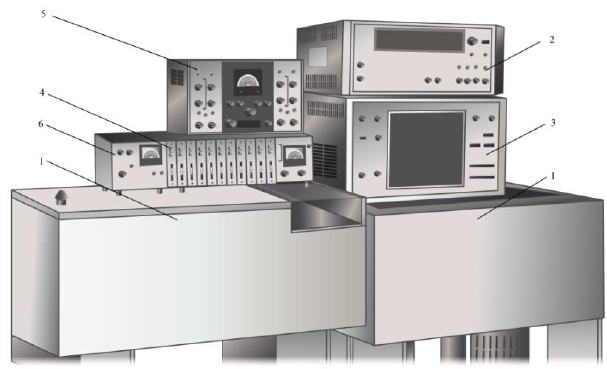
Figure 22. Test Unit Overview: 1 – centrifuge with rotor, 2 – F 5034 frequency meter, 3 – H 043.1 electromagnetic oscillograph, 4 – Topaz-3 DC amplifier, 5 – amplifier UT-4 AC amplifier, 6 – Agate power